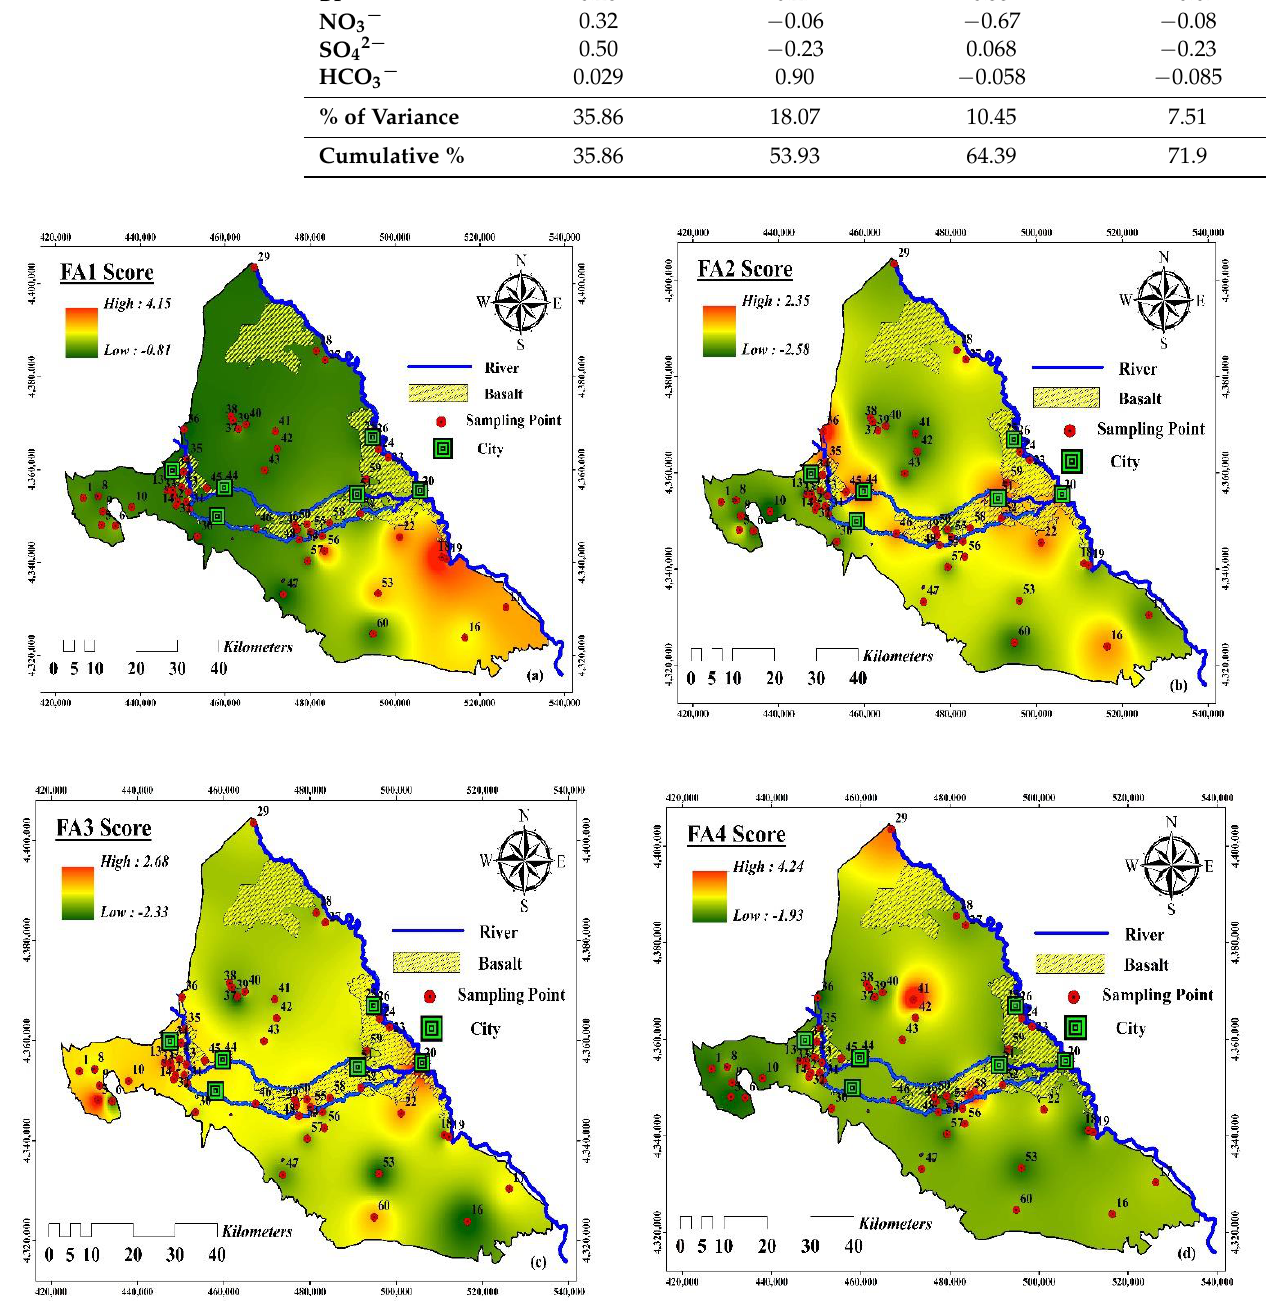
Figure 6. Spatial distribution of factors scores for the Maku–Bazargan–Poldasht area: ( a ) Factor 1 (FA1), ( b ) Factor 2 (FA2), ( c ) Factor 3 (FA3), ( d ) Factor 4 (FA4).